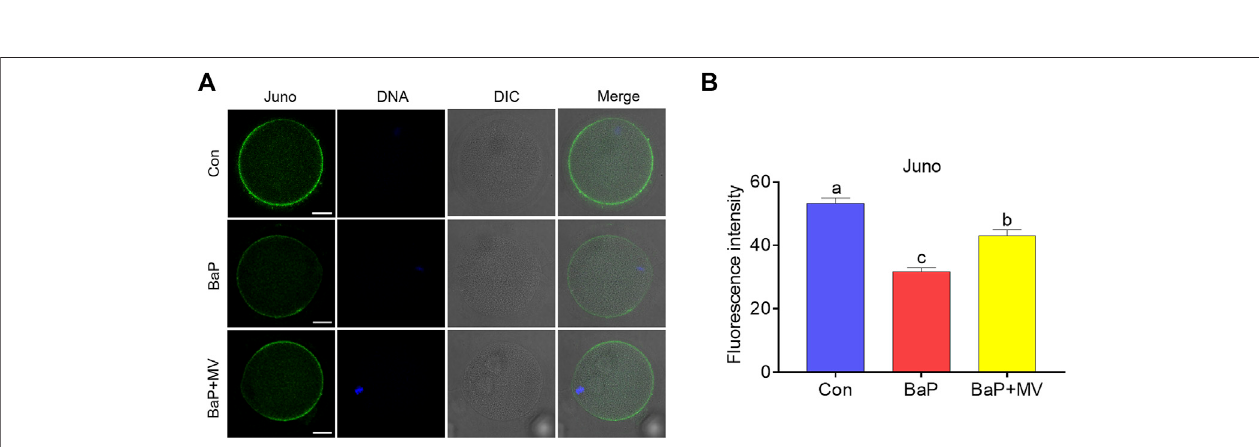
FIGURE4| Effects ofMV onJunoprotein levelsand distribution intheoocytesofBaP-exposedmice. (A) RepresentativeimagesofJuno fl uorescencesignalsand protein location in Con, BaP and BaP + MV oocytes. (B) The fl uorescence intensity of Juno in the Con, BaP and BaP + MV groups. Scale bar (cid:2) 25 μ m. The data are presented as the mean ± SEM. a-c Means not sharing a common superscript are signi fi cantly different ( p < 0.05).